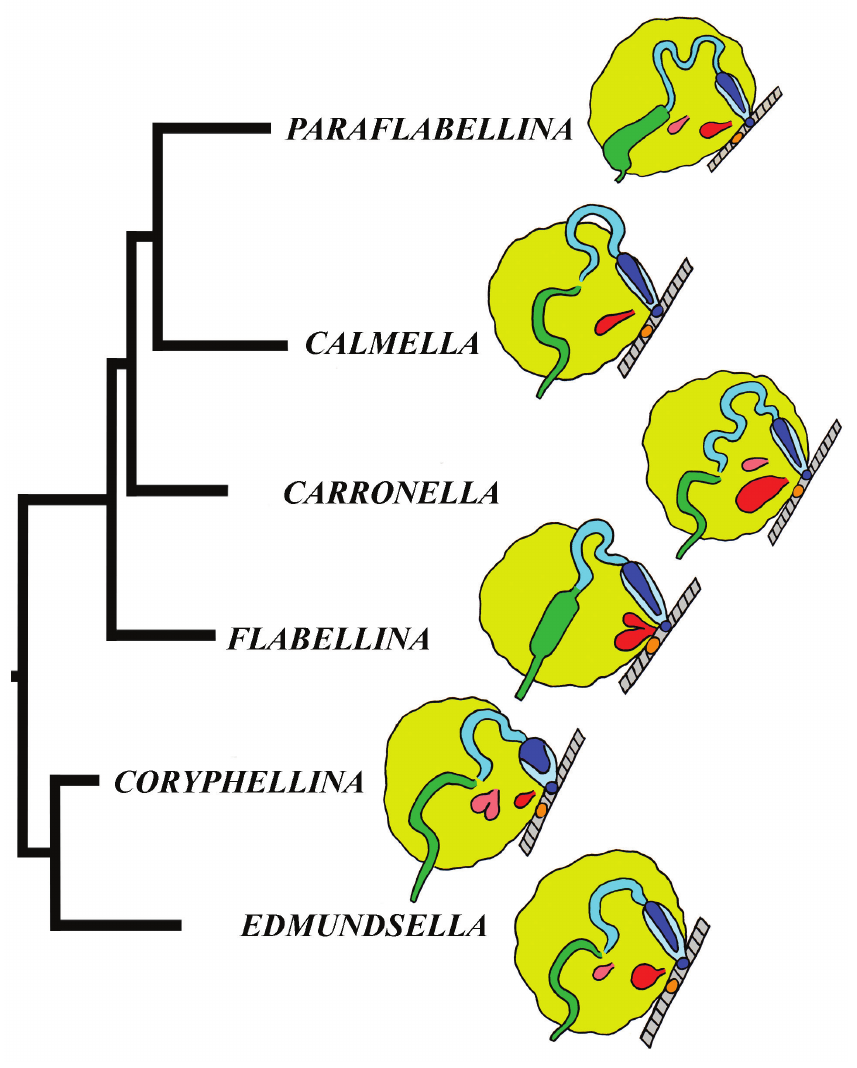
Figure 34. Schematic outline of the reproductive systems of the taxa of the family Flabellinidae inte- grated with molecular phylogenetic data. Colour indication of reproductive system characters: ampulla – green; body wall – gray; distal receptaculum seminis – red; female gland mass – yellow; female genital opening – orange; penis and male genital opening – dark blue; penial sheath – pale blue; prostatic vas deferens – turquoise; proximal receptaculum seminis –